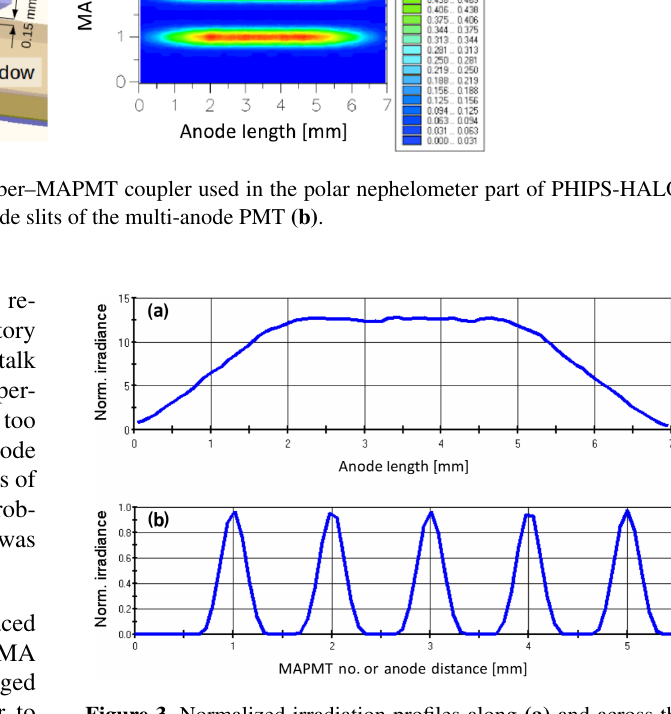
Figure 3. Normalized irradiation profiles along (a) and across the anode slits (b) of the MAPMT. The shaded areas in the lower panel indicate the width of the